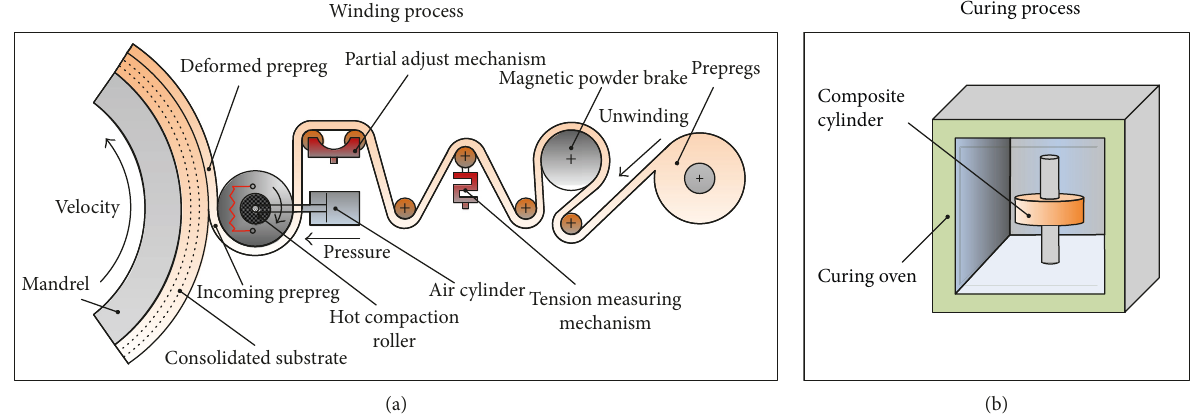
Figure 1: Manufacturing process of the composite wound cylinder. (a) Winding process. (b) Curing